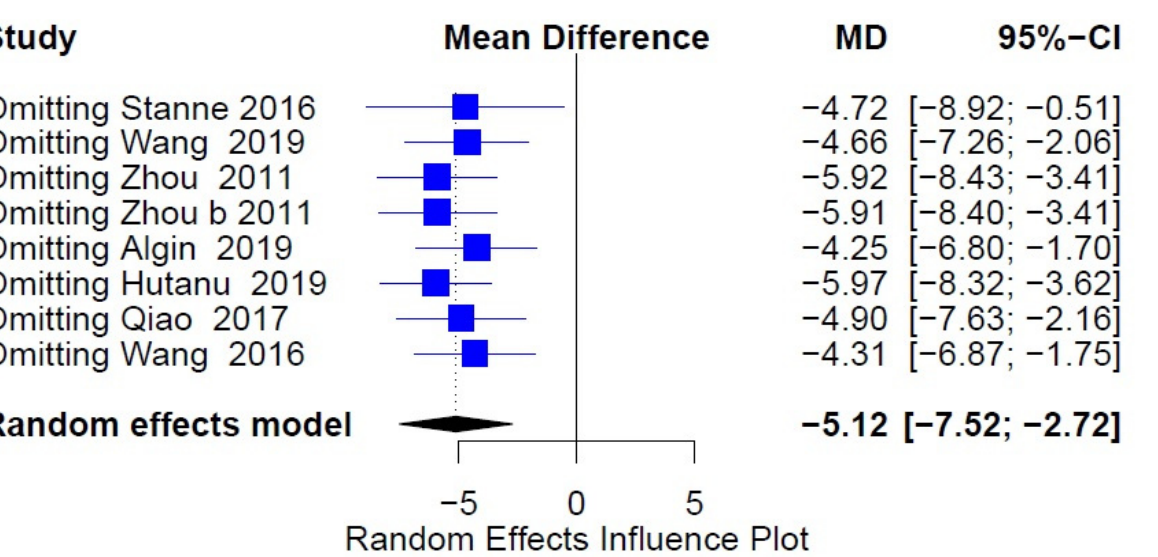
Figure 8. Sensitivity analysis serum BDNF in stroke patients versus controls.